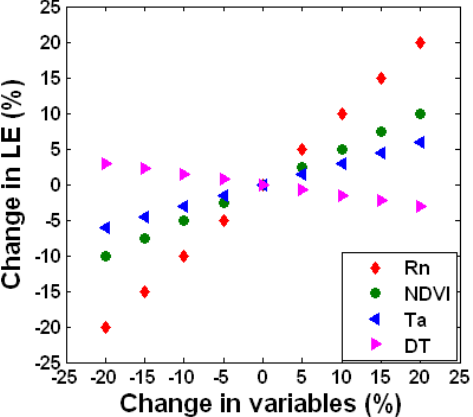
Figure 6. Sensitivity analysis of LE with net radiation, NDVI, DT, and air pressure near